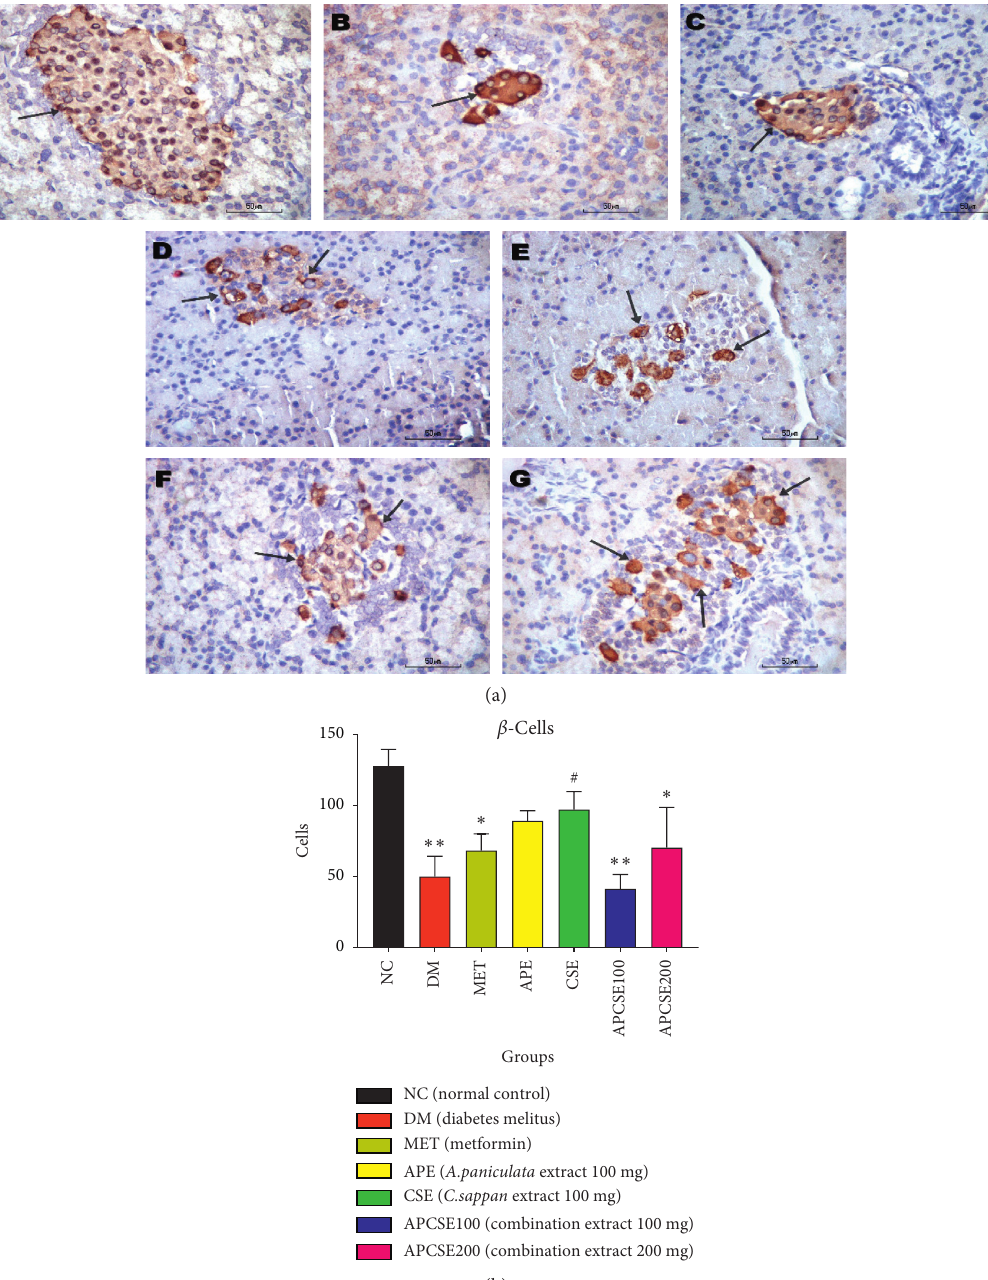
Figure 2: (a) Immunohistochemistry staining of pancreatic islets. (A) Section of the pancreas of the NC group showing immunoreactivity of insulin in β -cells occupying most of the islets; (B) the pancreas of the DM group showing a reduction in the immunohistochemistry expression of insulin in β -cells; (C) section from the MET group (diabetic rats +metformin) showing an apparent increase in the number and area of β -cells compared with the DM group; (D) section from the APE group (diabetic rats +APE 100mg) showing an apparent increase in the number and area of β -cells compared with the DM group; (E) pancreas from the CSE group (diabetic rats+CSE 100mg) showing an apparent increase in the number and area of β -cells compared with DM group; (F) section from the APCSE100 group (diabetic rats +APCSE 100mg) showing a lower density of insulin expressing β -cells; (G) the area from the APCSE200 group (diabetic rats +APCSE 200mg) showing an increase in insulin expressing β -cells with normal density. (b) β -Cell count of the pancreas. Results presented are mean ± SEM; significantly different from DM ( # p < 0 . 05 ; ## p < 0 . 01 ) and significantly different from normal ( ∗ p < 0 . 05 ; ∗∗ p < 0 . 01 )